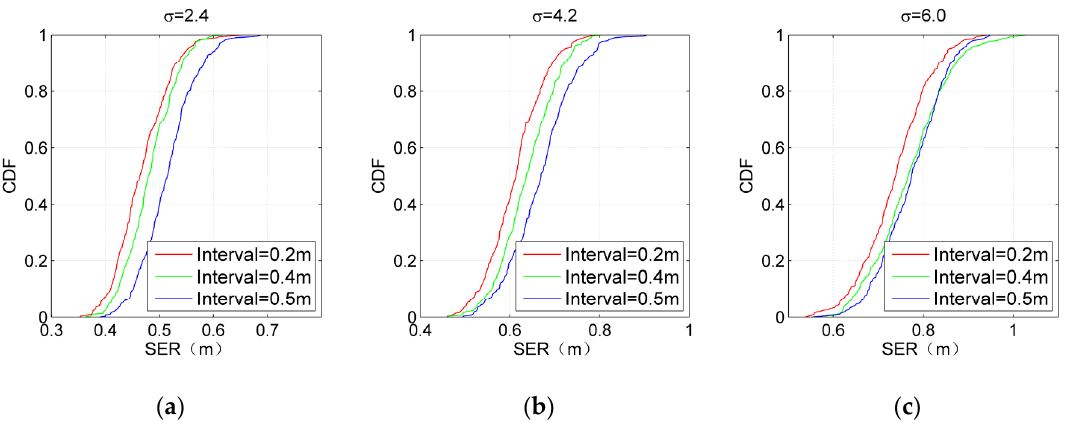
Figure 12. Single estimated error (SER) of IKULDAS under various reference tag densities and σ . ( a ) σ = 2.4. ( b ) σ = 4.2. ( c ) σ = 6.